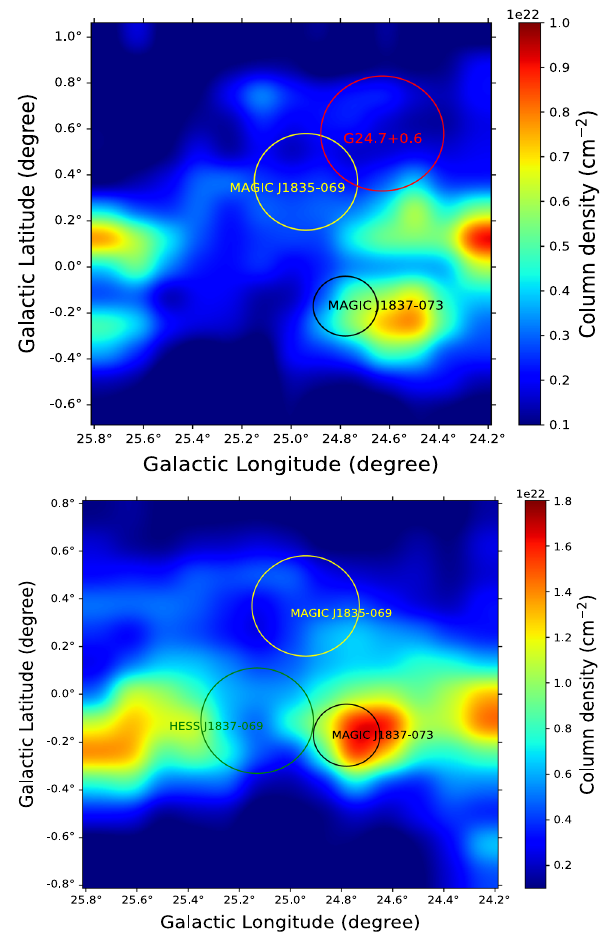
Fig. 1 H 2 column density obtained from the carbon monoxide (CO) composite survey. Top: H 2 column density of gas content integrated over the velocity interval from 21 to 41 km s − 1 which corresponds to 3.5 kpc. Bottom: H 2 column density of gas content integrated over the velocity interval from 78 to 98 km s − 1 which corresponds to 6.6 kpc